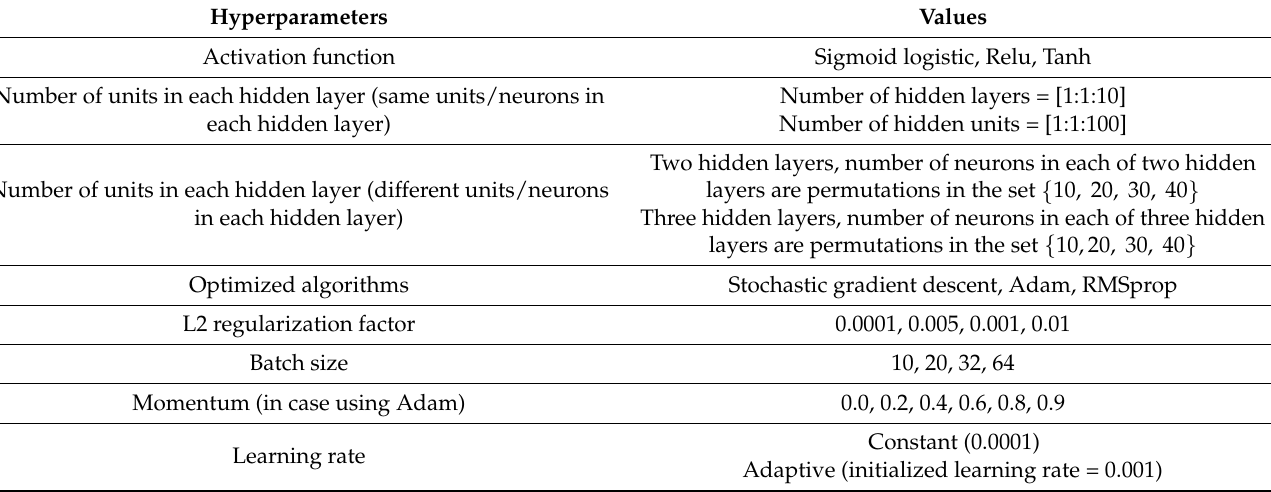
Table 2. Tuning values of hyperparameters.